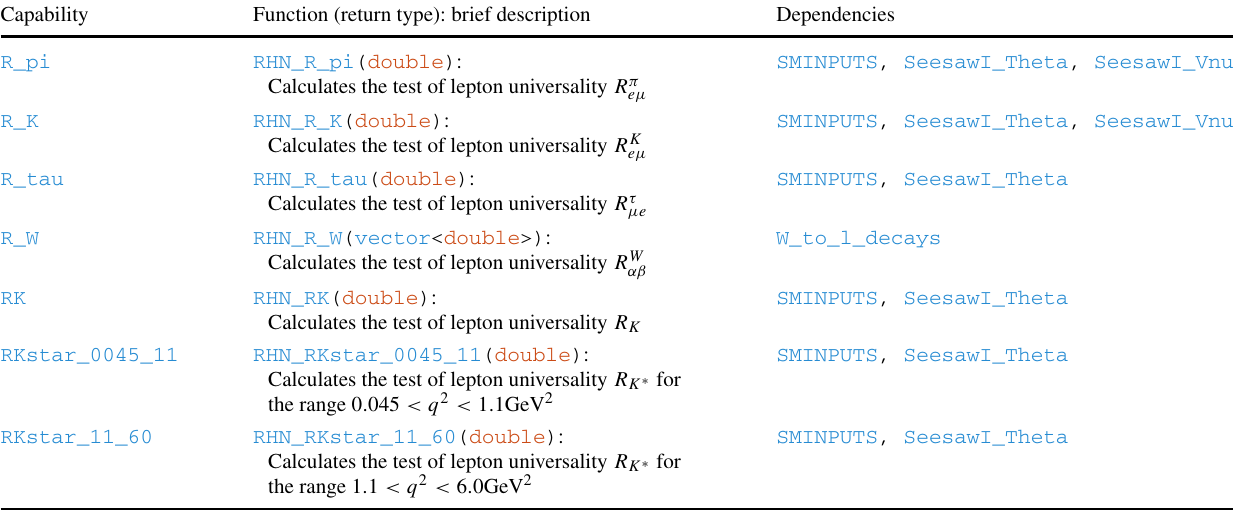
Table 13 Capabilities and module functions that calculate lepton universality observables Capability